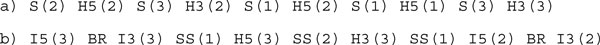
RNA expression. RNA expression for the structures in Figure 1.